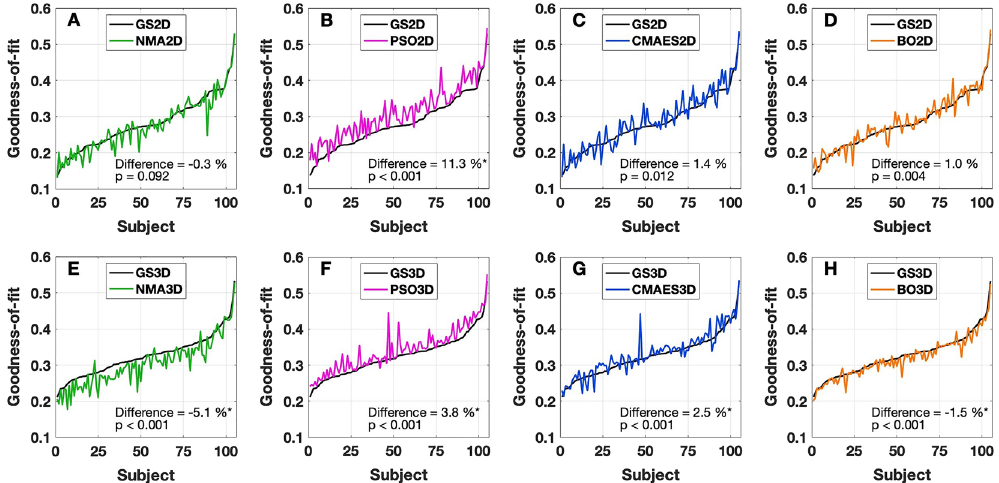
Figure 4. Goodness-of-fit values for individual subjects and optimization approaches. As indicated in the legends, colored curves illustrate the outcome (subject-dependent goodness-of-fit) for each method in the ( A – D ) 2Dim (NMA2D, PSO2D, CMAES2D, BO2D) and ( E – H ) 3Dim (NMA3D, PSO3D, CMAES3D, BO3D) cases. The subjects are sorted in ascending order, based on the maximal fitting values detected by the grid search (black curves) in 2Dim and 3Dim (GS2D and GS3D, respectively). The medians (across subjects) of the relative differences between the results of the optimization algorithms and the grid search are indicated in the plots together with p -values of the Wilcoxon signed-rank test. Statistically significant differences are marked with an asterisk (the significance level of 5%, p < 0.05, has been Bonferroni-corrected for multiple comparisons). The figure was created with MATLAB R2018a (www. mathw orks. com).